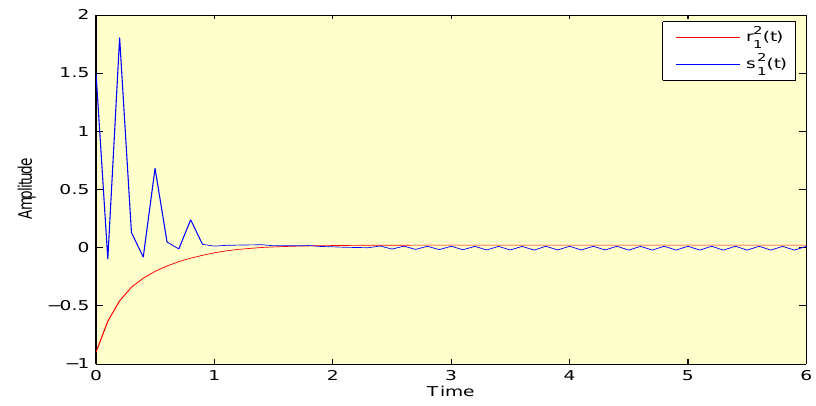
Figure 7. Time responses of state variables (cid:114) 2